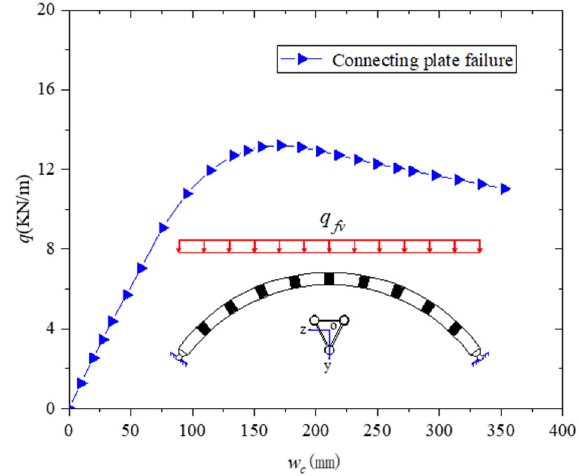
Figure 25. Load–displacement curve during connecting plate failure.